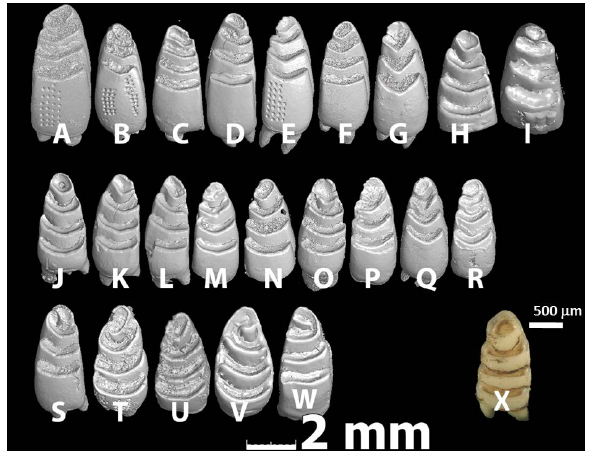
Figure 7: Comparison between fossil and modern Otomys species (M